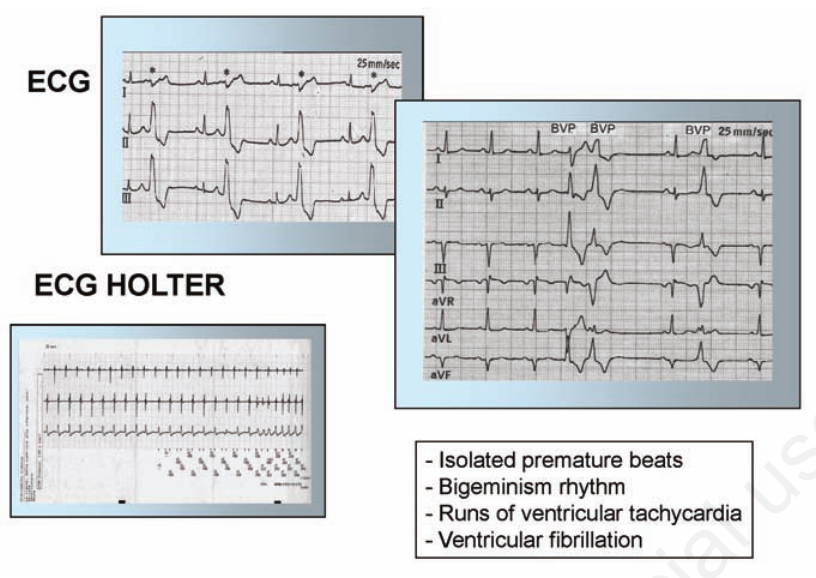
Figure 6. Arrhythmogenic stage of dystrophinopathic cardiomyopathy: electrocardio- graphic signs.